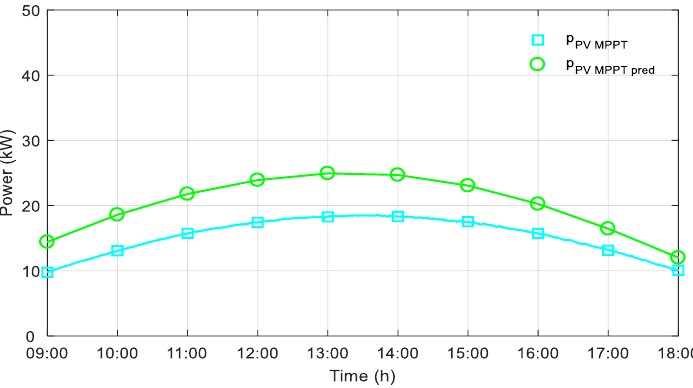
Figure 5. PV MPPT real and predicted powers — case 1.